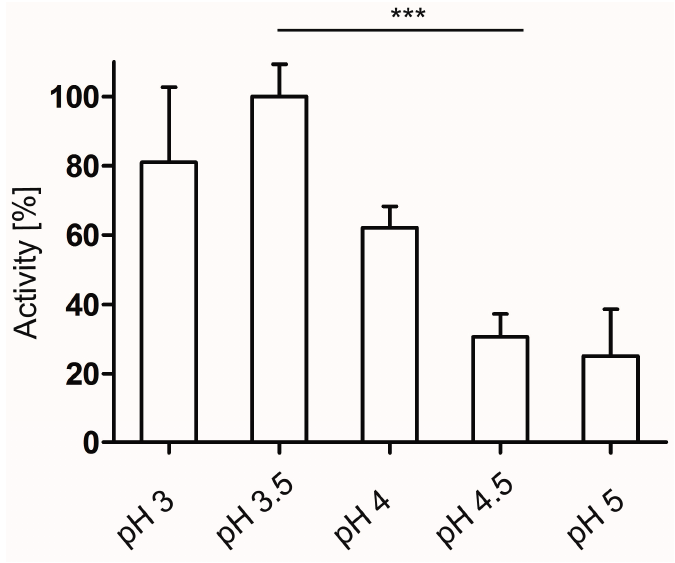
Figure 5. Activity measurement of Hyal-1 displayed on E. coli F470 at different pH